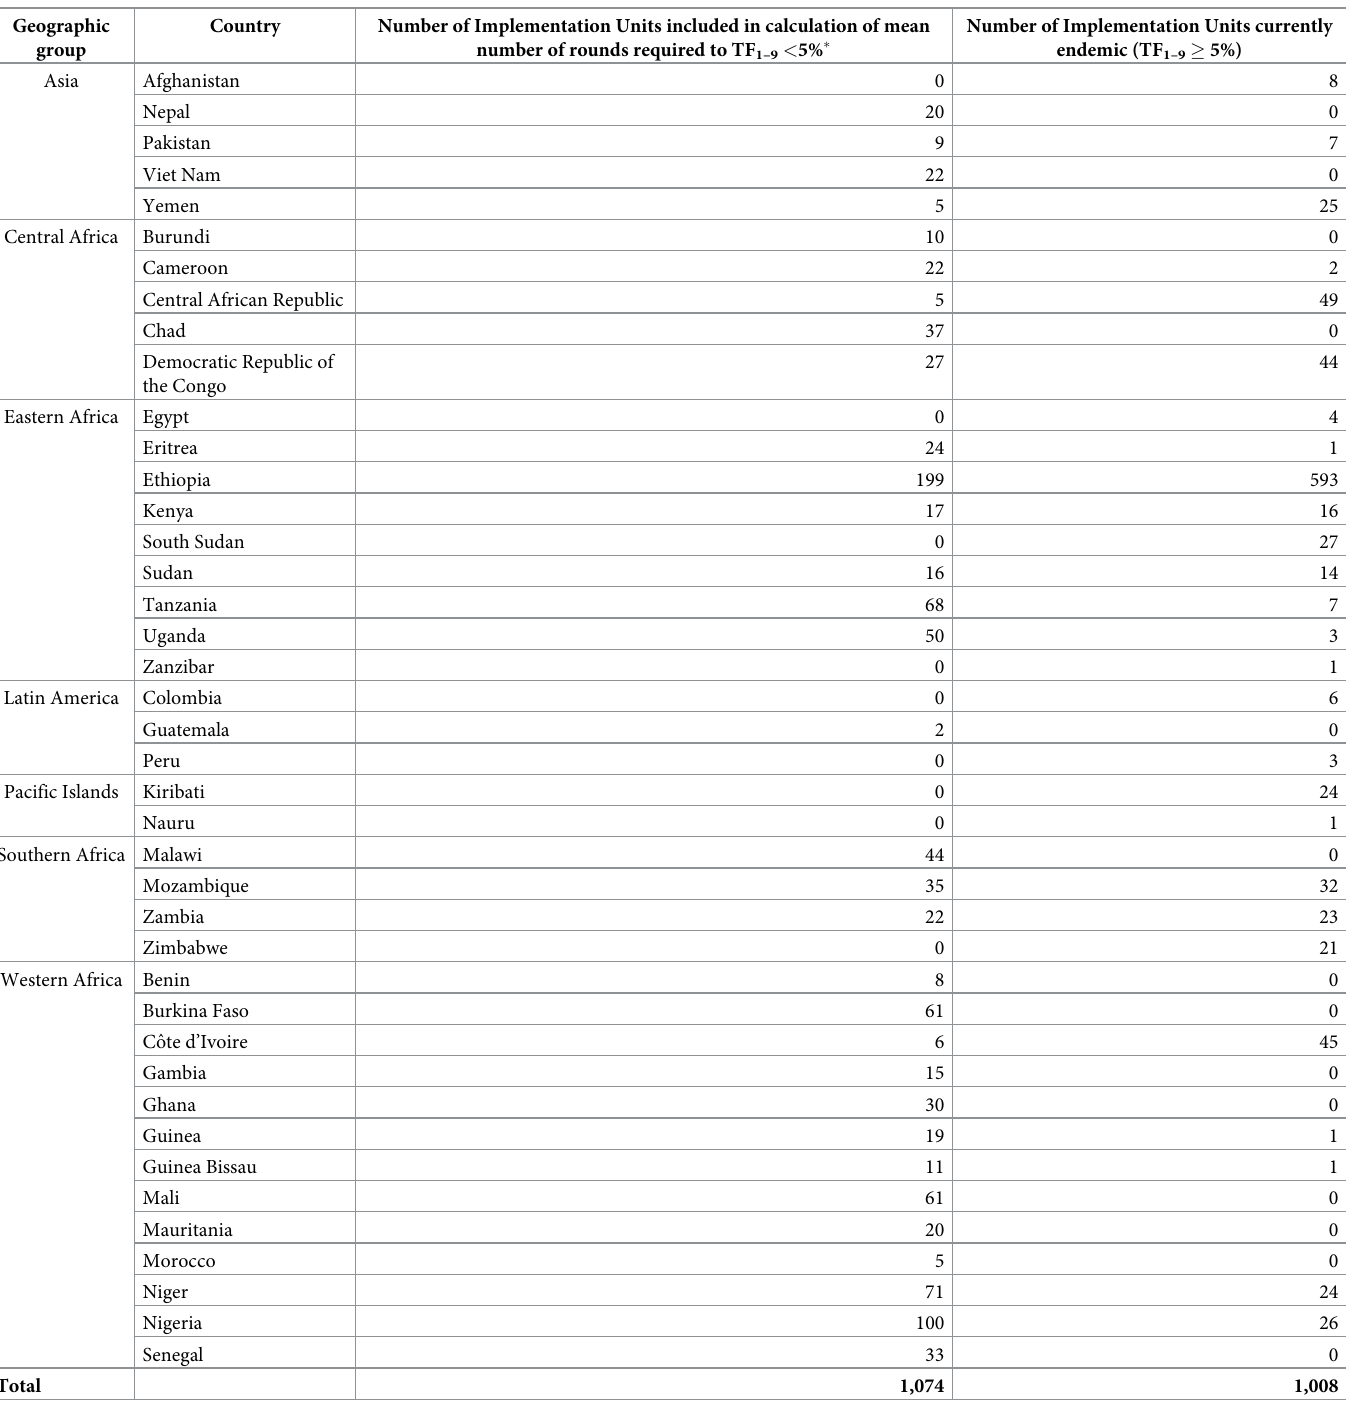
Table 1. Characteristics of data included. Geographic